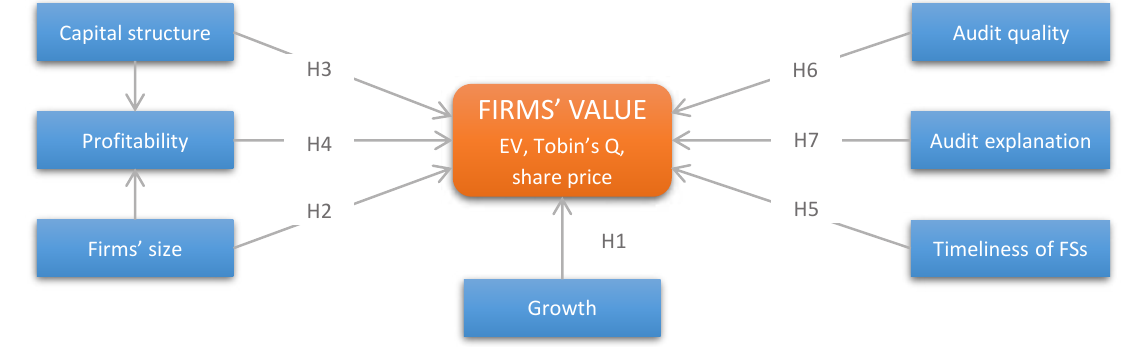
Figure 1. Research model of factors affecting the firms’